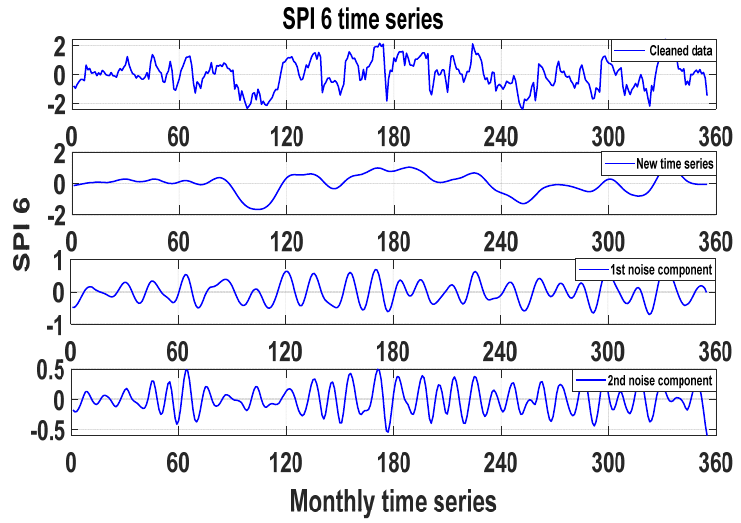
Figure 4. Cleaned SPI 6 time series (first line) and components of SPI 6 obtained by SSA (second to fourth lines). The second line represents the new time series, while the third and fourth represent noise signals. Table 3. Statistics of collinearity for the chosen best input